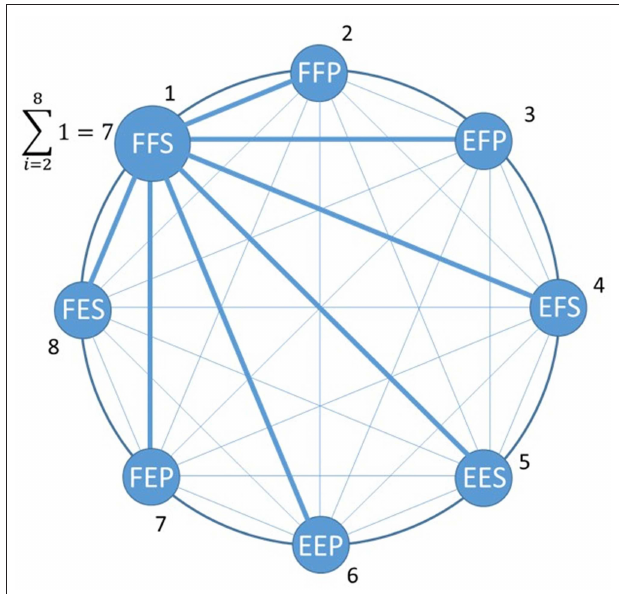
FIGURE 4 | Posture classification example where the maximum number of paired posture classification is 8*(8–1)/2 = 28. Out of those there are 21 thin blue lines representing paired posture classifier associated with postures other than FFS which were taken by a subject. Associated with FFS are seven paired classifiers (large blue lines) which make correct classification with FFS.